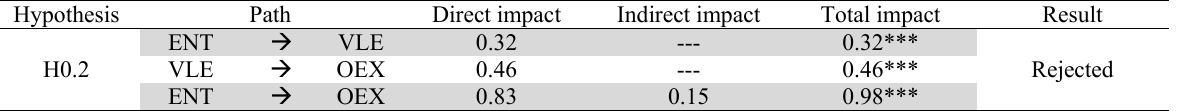
Testing the mediating role of visionary leadership between the relationship of entrepreneurship and organizational excel- lence